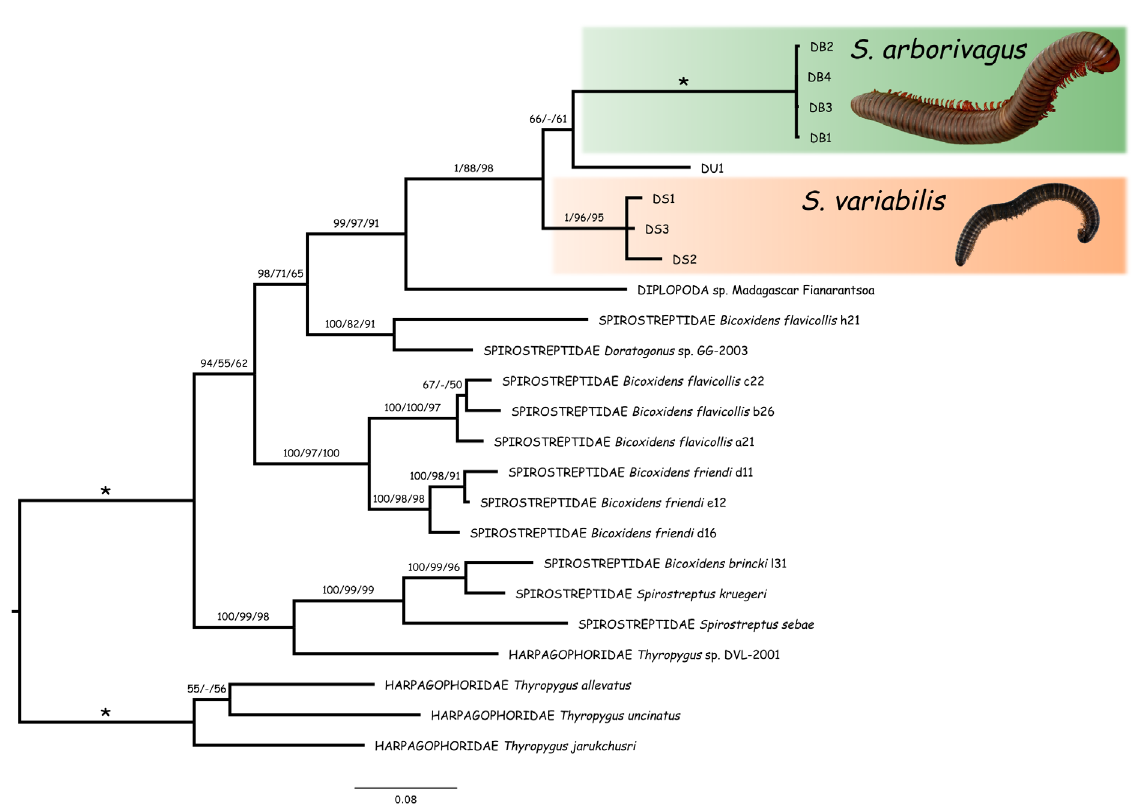
Fig. 1. Bayesian Inference tree resulting from the MB analysis based on the COI–16S dataset, showing relationships between Sechelleptus arborivagus sp. nov. and other relatives of the family Spirostreptidae Brandt, 1833 and outgroups Harpagophoridae Attems, 1909. The tree is congruent in its topology with the PB and ML analyses of the same dataset. Nodal support values (MB and PB posterior probabilities and ML Bootstrap) are indicated as following: MB/PB/ML. Stars designate absolute supports (i.e. , 100 in all three analyses), and hyphens indicate collapsed nodes in the PB